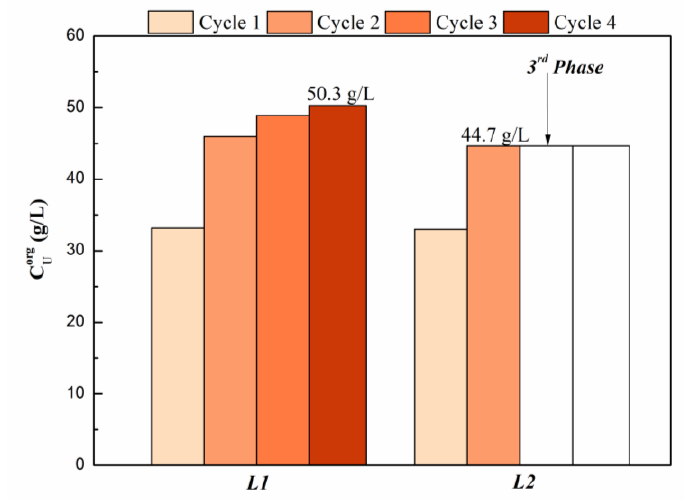
Figure 5. Uranium(VI) loading capacity of L .